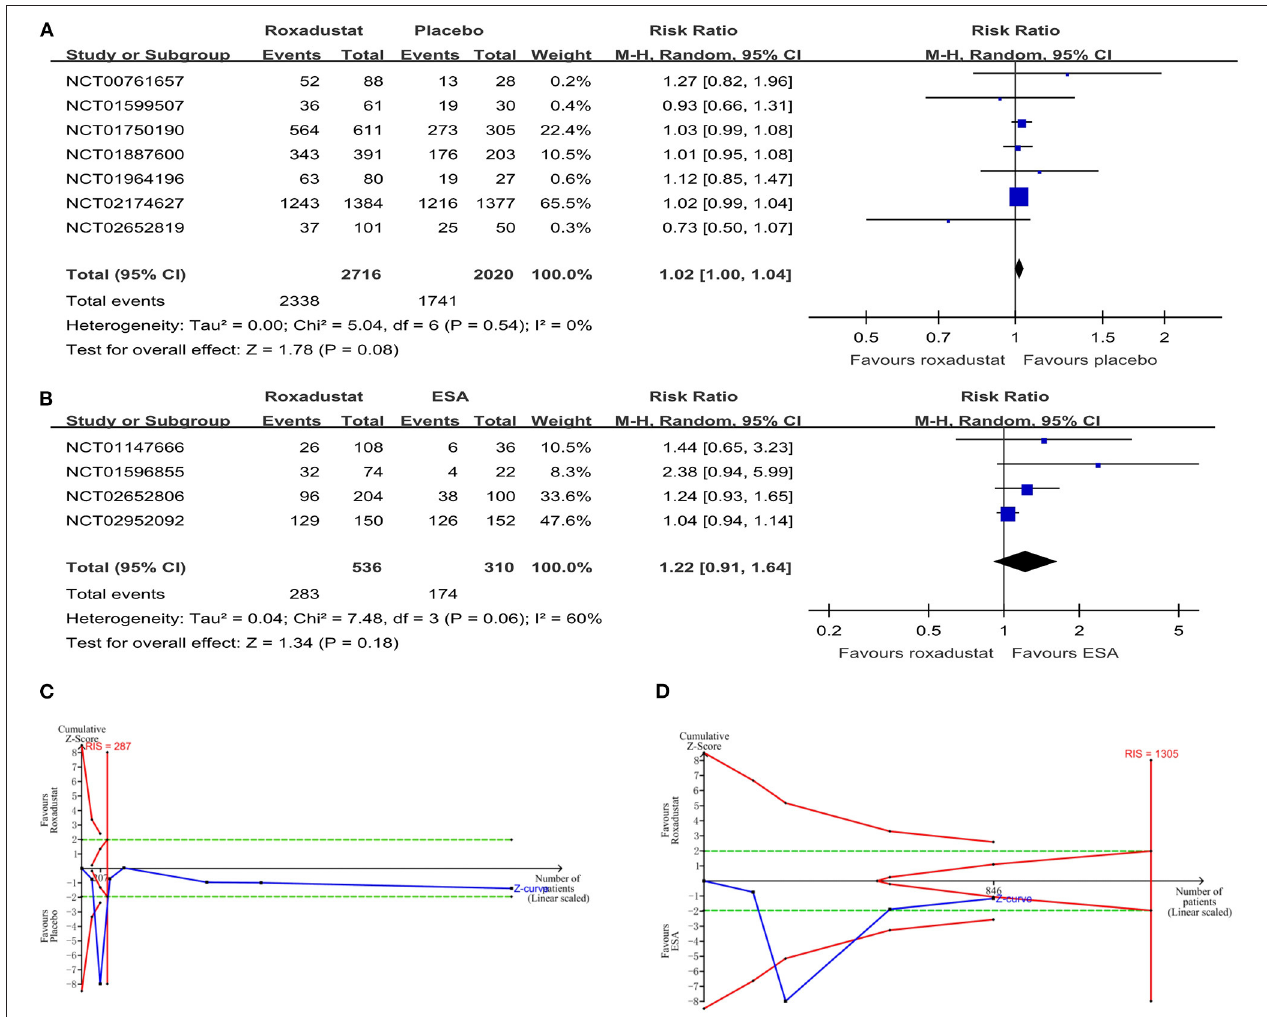
FIGURE 3 | The safety of roxadustat. (A) Forest plot of the safety of roxadustat and the placebo in NDD-CKD patients. (B) Forest plot of the safety of roxadustat and epoetin alfa in DD-CKD patients. (C) Random effects model of the TSA of safety of roxadustat and the placebo in NDD-CKD patients. A diversity-adjusted information size of 287 participants was calculated based on an adverse event rate of 86.2% in the placebo group and a relative risk reduction (RRR) of 20%, with α = 5% (two-sided), β = 20%, and I 2 = 0%. The solid blue line represents the cumulative Z-curve, which crossed the futility boundary (solid red line). (D) Random effects model of the TSA of safety of roxadustat and ESA in DD-CKD patients. A diversity-adjusted information size of 1,305 participants was calculated based on an adverse event rate of 56.1% in the ESA group and an RRR of 20%, with α = 5% (two-sided), β = 20%, and I 2 = 60%. The solid blue line represents the cumulative Z-curve, which crossed the conventional boundary (dashed green line) but did not cross the trial sequential monitoring boundary (solid red line). CKD, chronic kidney disease; CI, confidence interval; DD, dialysis-dependent; ESA, erythropoiesis-stimulating agents; NDD,